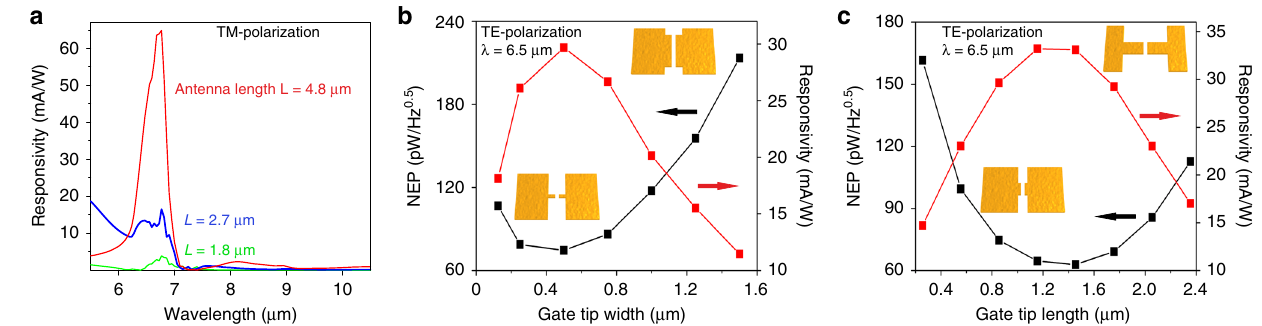
Fig. 4 Dependence of the simulated responsivity and NEP on the geometry of the antenna and H-shaped gates. a Simulations of responsivity for TM- polarization for different antenna lengths. Different cases are presented: non-resonant antenna within the hBN RB spectral range (antenna total length of L = 1.8 μ m, shown in green), semi-resonant antenna ( L = 2.7 μ m shown in blue, which corresponds to the experimental antenna) and resonant antenna ( L = 4.8 μ m, shown in red). b Simulations of responsivity and NEP as a function of gate tip width and graphene (following the exact shape of the gates) as shown in the schematic for TE-polarization at λ = 6.5 μ m. The tip length is 855 nm, which includes the gap between the gates of 155 nm. The source-drain distance is 2.6 μ m and electrodes width is 2 μ m as in the measured device. c Same as b but as a function of the gate tip length as shown in schematic.